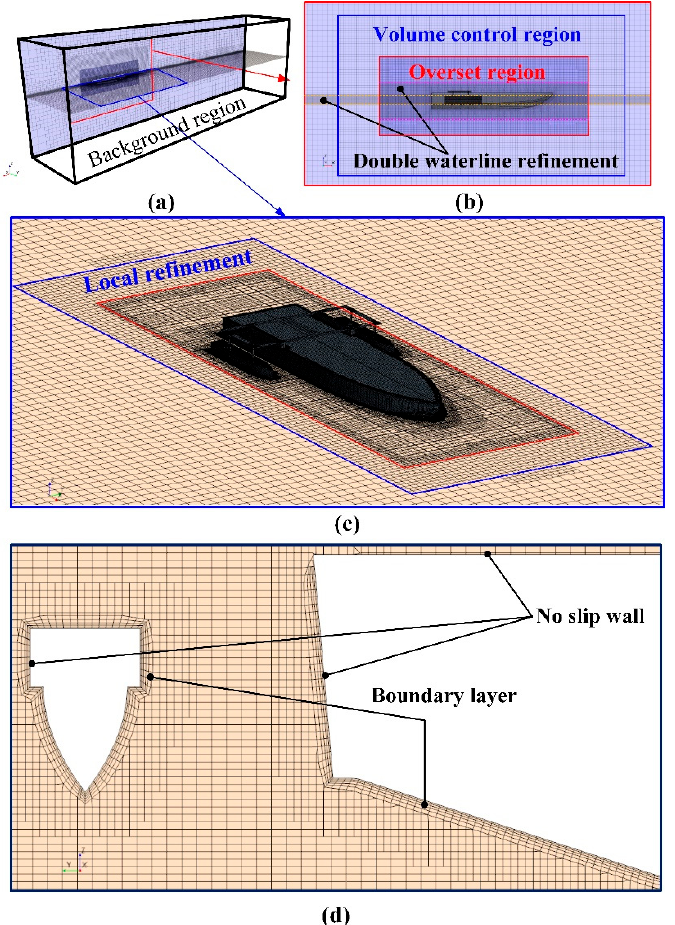
Figure 8. Detailed grid partition of the entire computational domain: ( a ) axis view; ( b ) front view; ( c ) vertical view; ( d ) partial view.